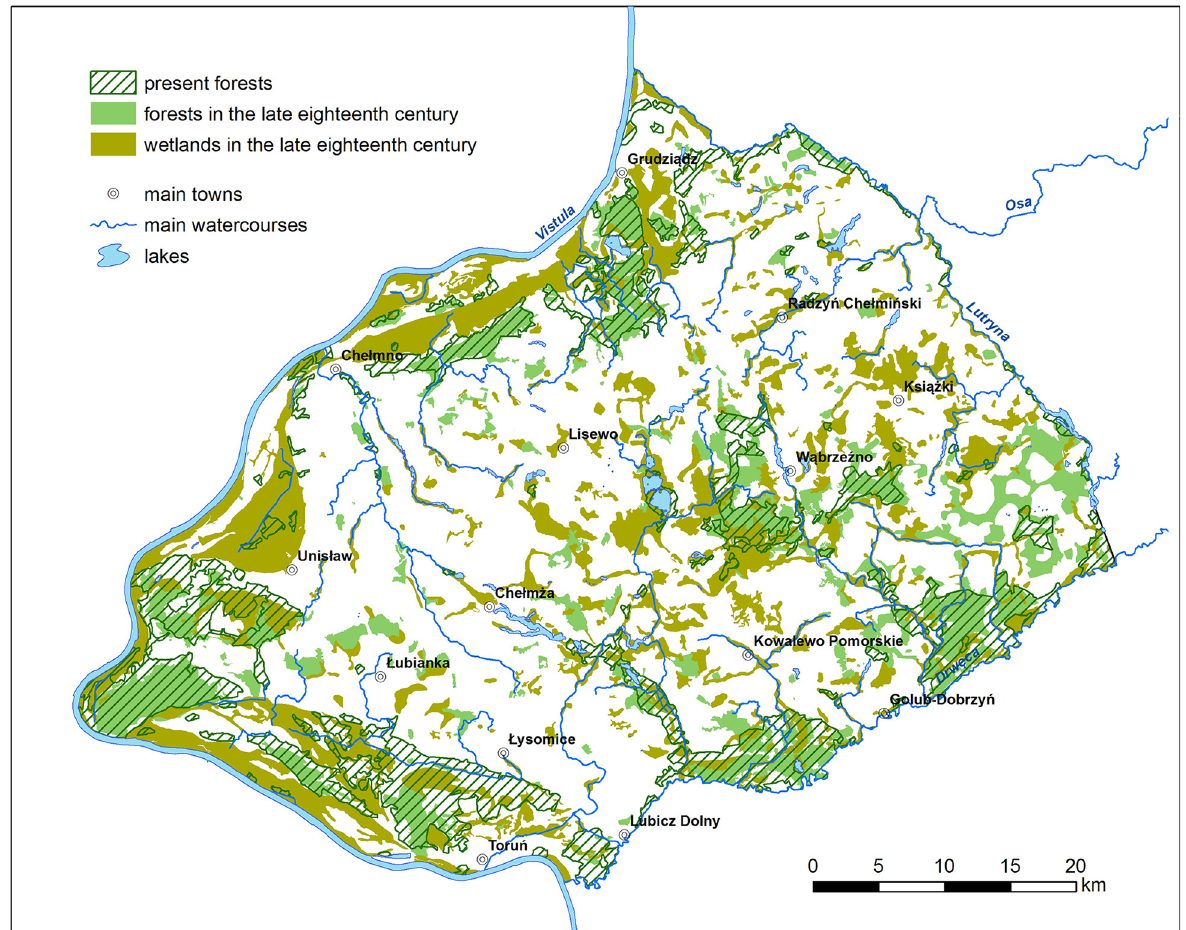
Fig. 9. Extent of forests: modern day (based on the Data of Head office of Geodesy and Cartography, Poland), the late 18th century (based on the Schrötter map from 1802) and wetlands (based on the Schrötter map from 1802 and the Map of Polish wetlands (IMUZ